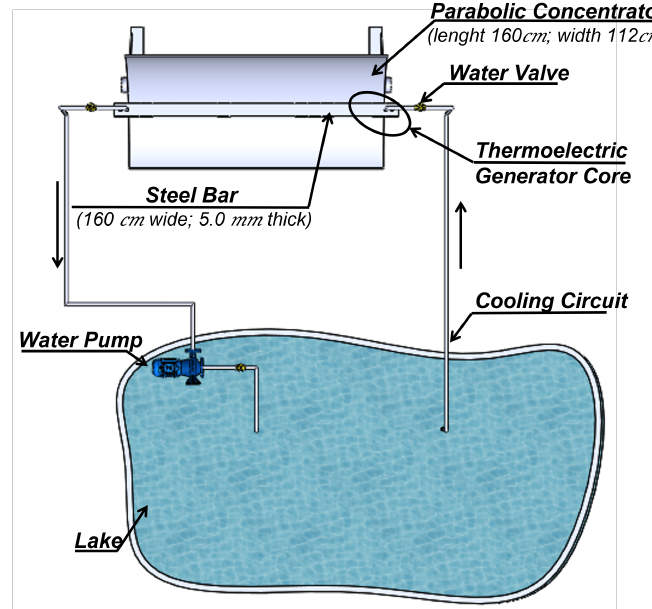
Figure 2. Schematics of the generator setup of the cylindrical-parabolic collector with dimensions. Main parts are indicated on the